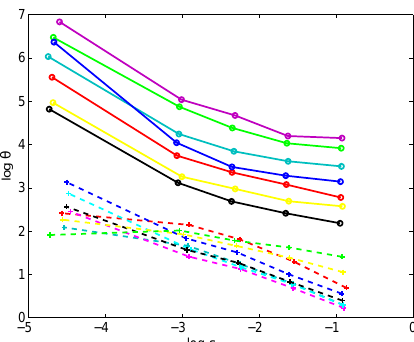
Fig. 12. Representation of the relationship between base rate and odds ratio on a log-log scale at site FB 699m depth. The lines showing an upward trend refer to levels close to 699m (from 599 to 774m depth), while the ones showing a downward trend when the threshold increases refer to levels more distant from the reference depth.